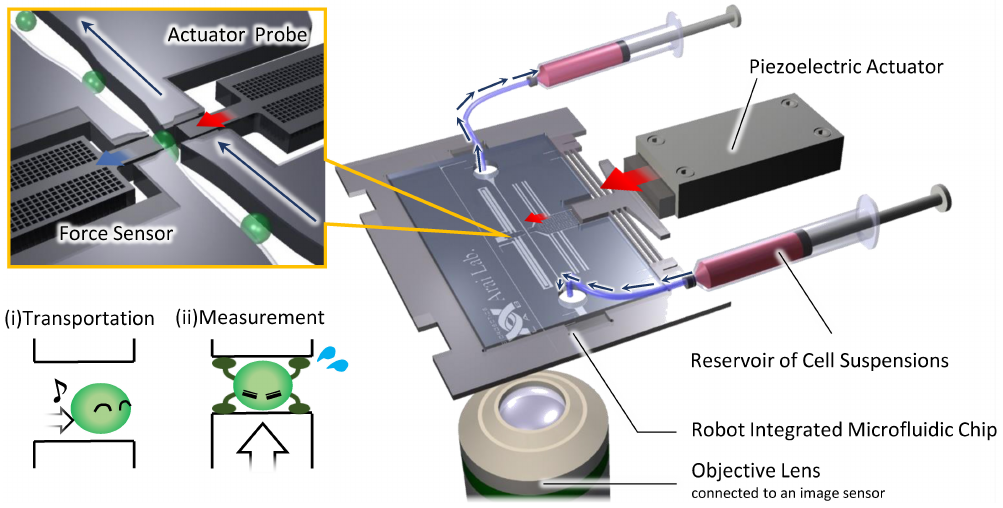
Figure 1. Overview of the on-chip measurement system for cellular mechanical